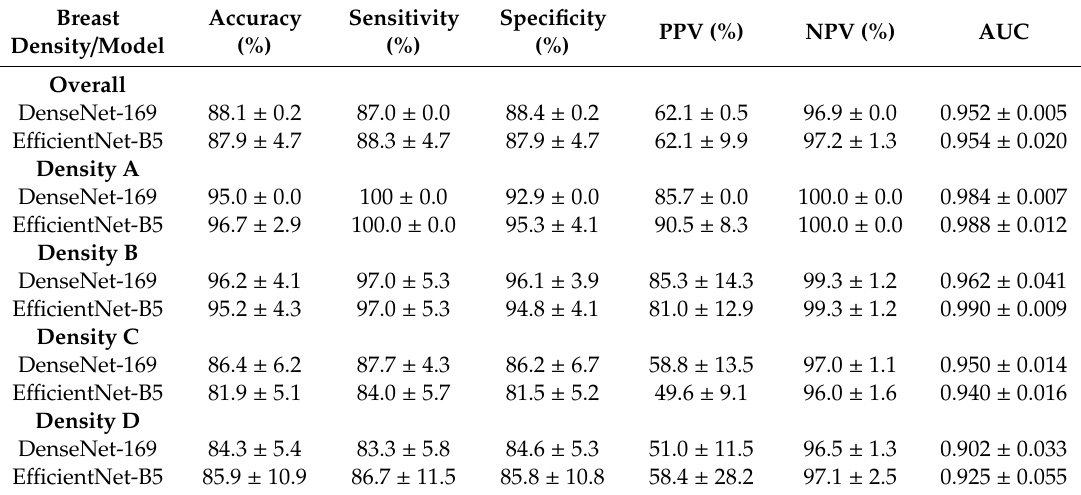
Table 2. Performances of deep learning models for breast cancer detection in mammograms by breast density.